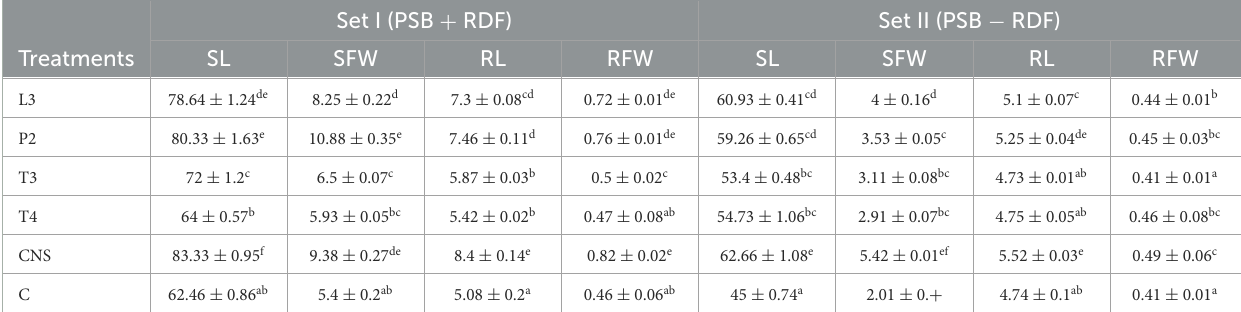
TABLE 2 Agronomic parameters of PSB treatments with two different sets Set I (PSB + RDF) and Set II (PSB − RDF) at 90 days post-inoculation (DPI), respectively, where SL, shoot length; RL, root length; SFW, shoot fresh weight; RFW, root fresh weight. Set I (PSB +